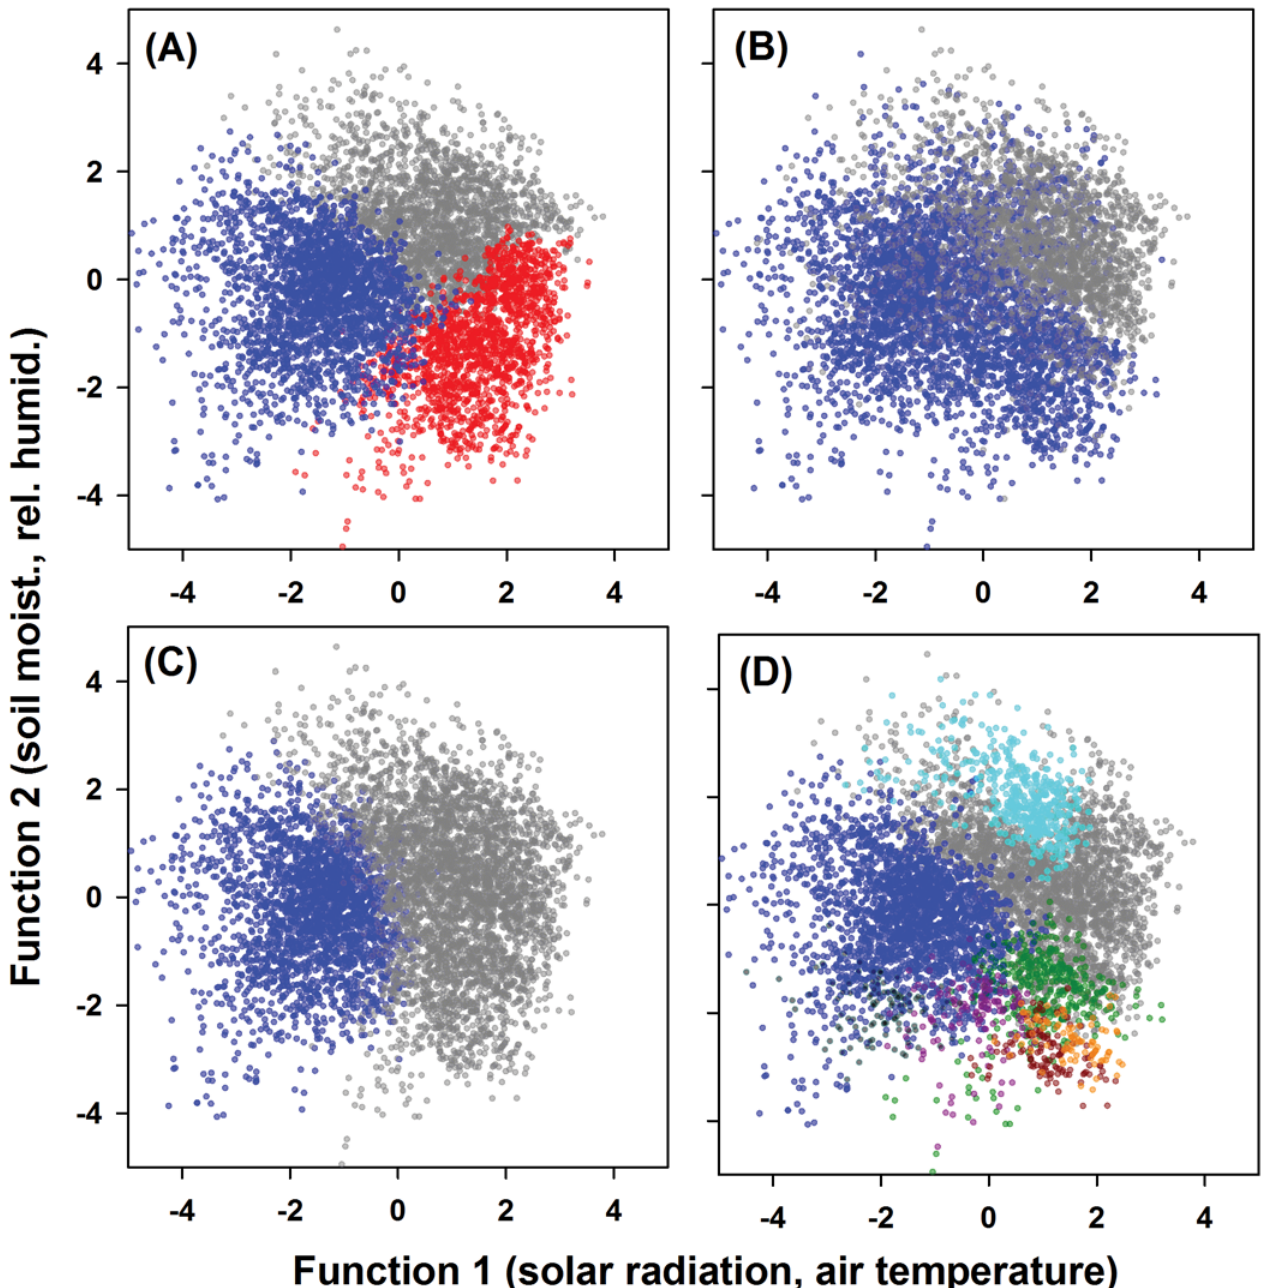
Figure 3. The “ fire-weather plane ” describing 13 years of fire weather. The plane is defined by the two discriminant functions described in Table 1. Panels include: (A) the seasons of the representative model (wet season, gray dots; dry season, blue dots; fire season, red dots). (B) The wet and dry seasons of the CRA model. (C) The wet and dry season of the “ best ” model with 2 clusters. (D) The “ best ” model with 8 clusters (clusters 3 – 8 are colored differently than the seasons found in the other panels).